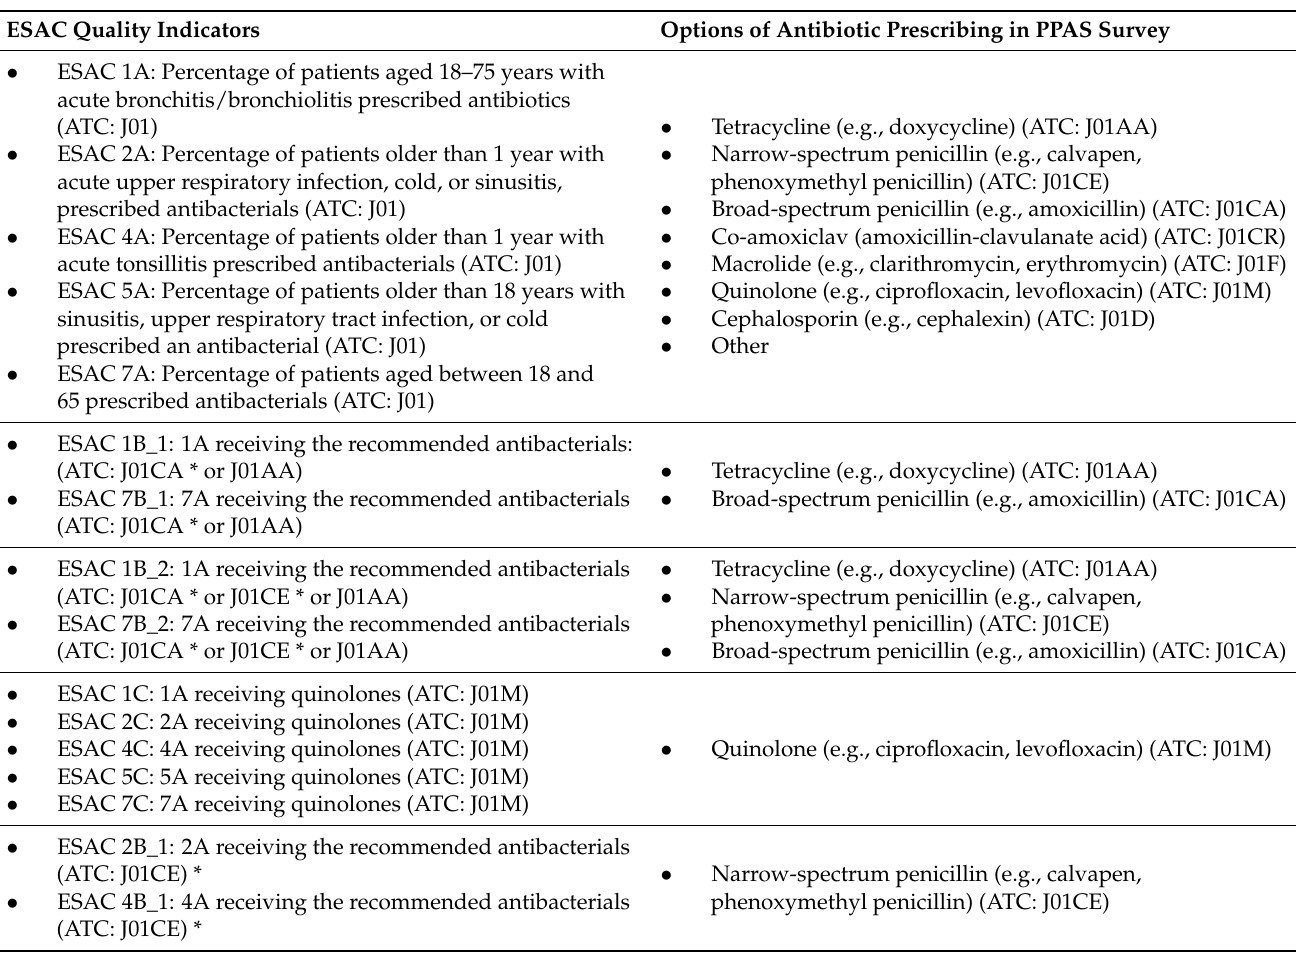
Table 4. Allocation of antibiotic prescribing from PPAS survey options to ESAC Quality Indicators. ESAC Quality